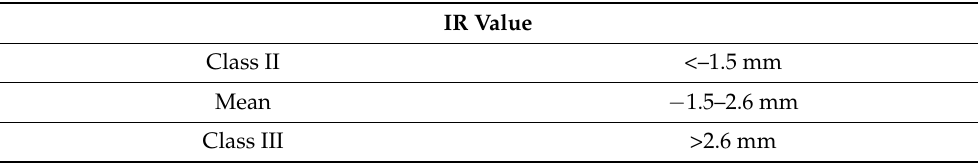
Table 9. Identification of intervals regarding the reciprocal relation between the upper jaw and mandible. This spatial value is defined as